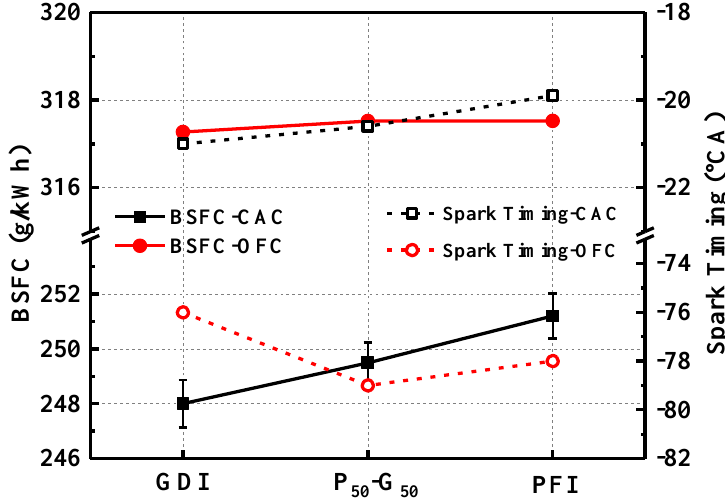
Figure 8. Comparison of BSFC and spark timing between CAC and OFC.